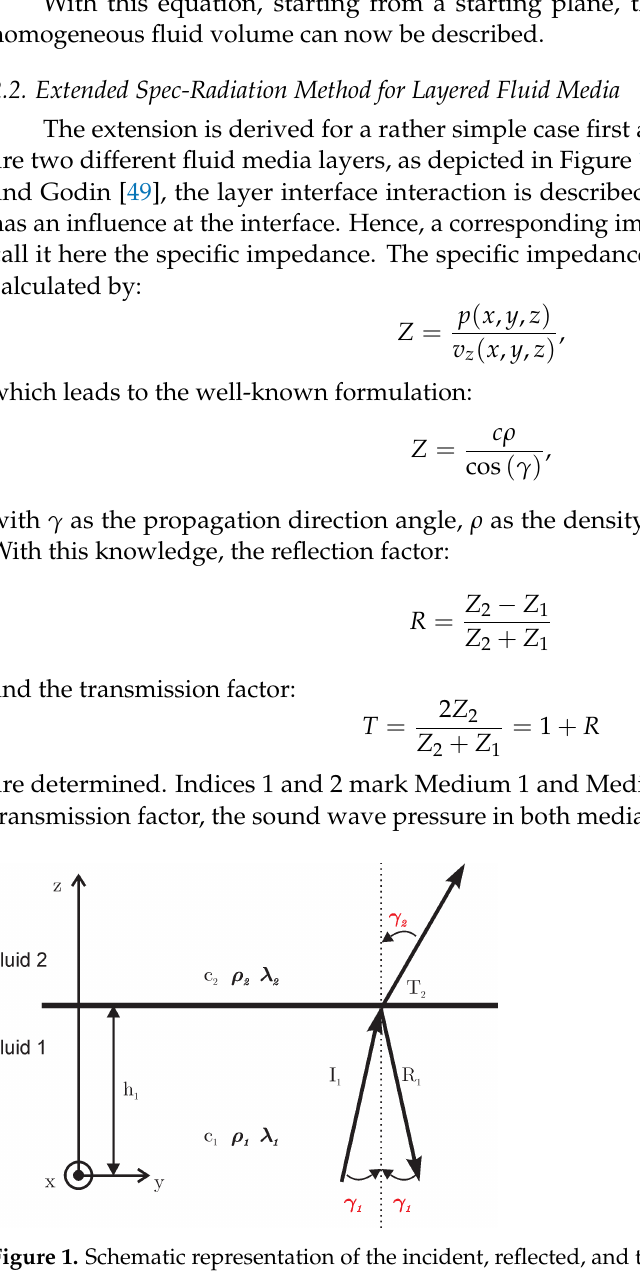
Figure 1. Schematic representation of the incident, reflected, and transmitted waves at a fluid–fluid interface in a semi-infinite volume. Included are the speed of sound c 1 and c 2 , the densities ρ 1 and ρ 2 , and the wavelengths λ 1 and λ 2 of the two fluid